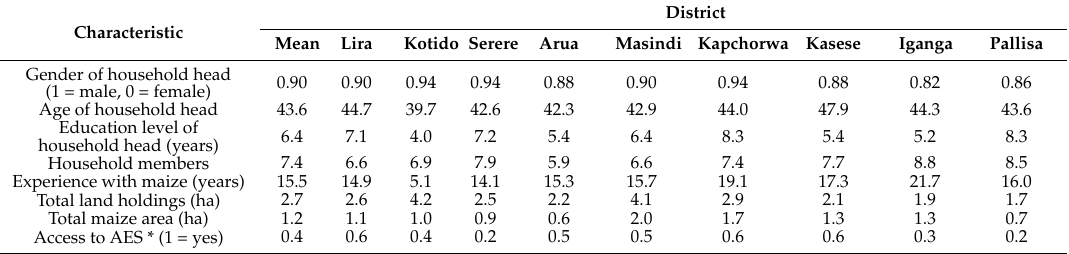
Table 1. Basic characteristics of the farmers participating in the survey conducted in 2015. Shown are averages for 50 farmers in each district.